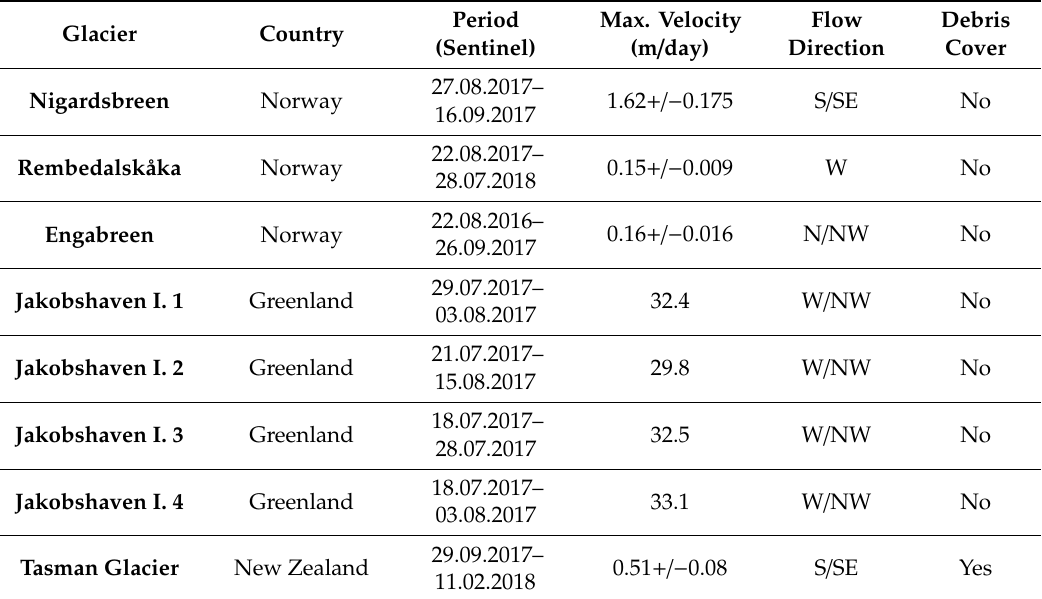
Table 2. Summary of maximum velocities from Sentinel-2 feature tracking using SenDiT on example glaciers.